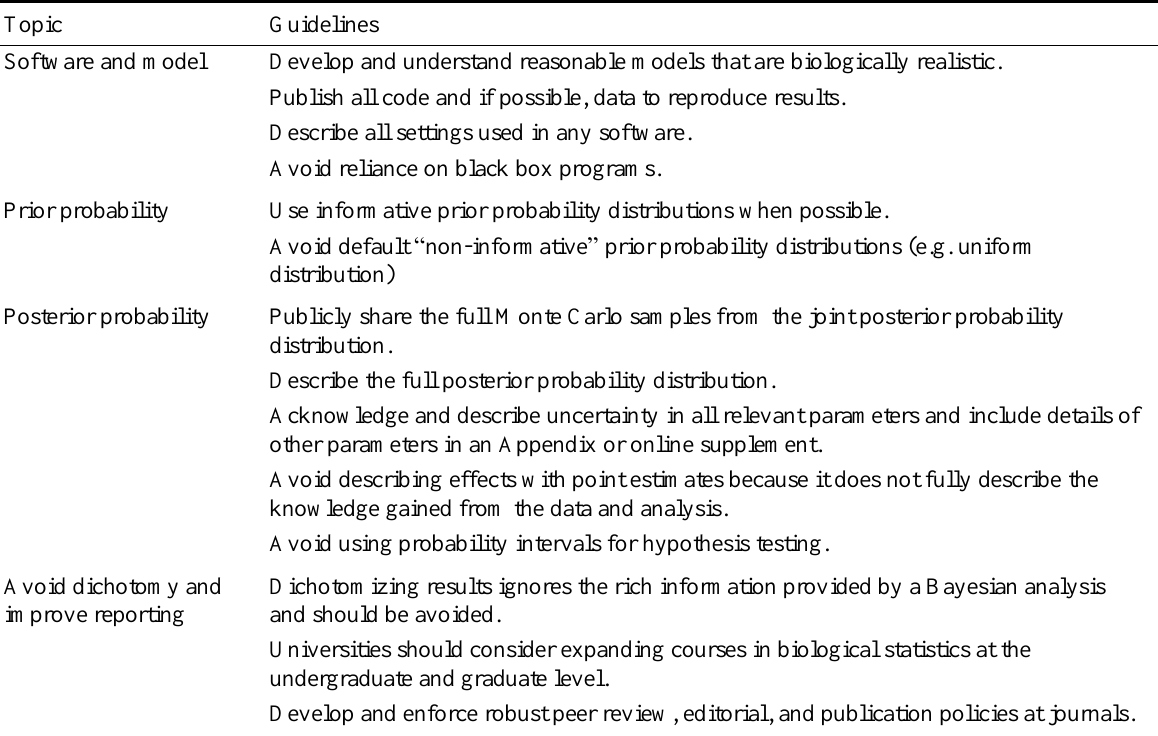
Table 1. Some recommendations for more effective use of Bayesian inference in